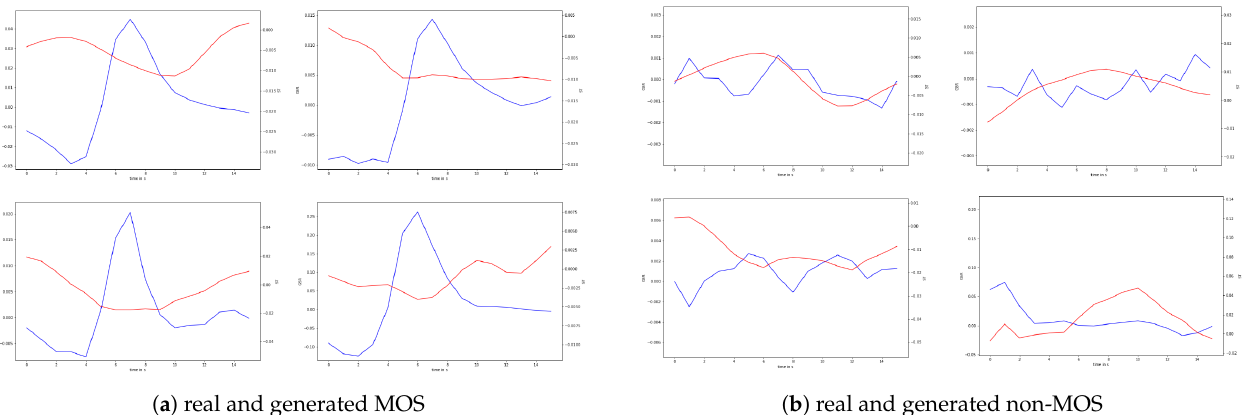
Figure 6. Visual comparison of real and generated samples. The red line shows a standardized and filtered 16 s ST signal. The blue line shows a standardized and filtered 16 s GSR signal. There are always two generated and two real signal samples arranged in a 2 × 2